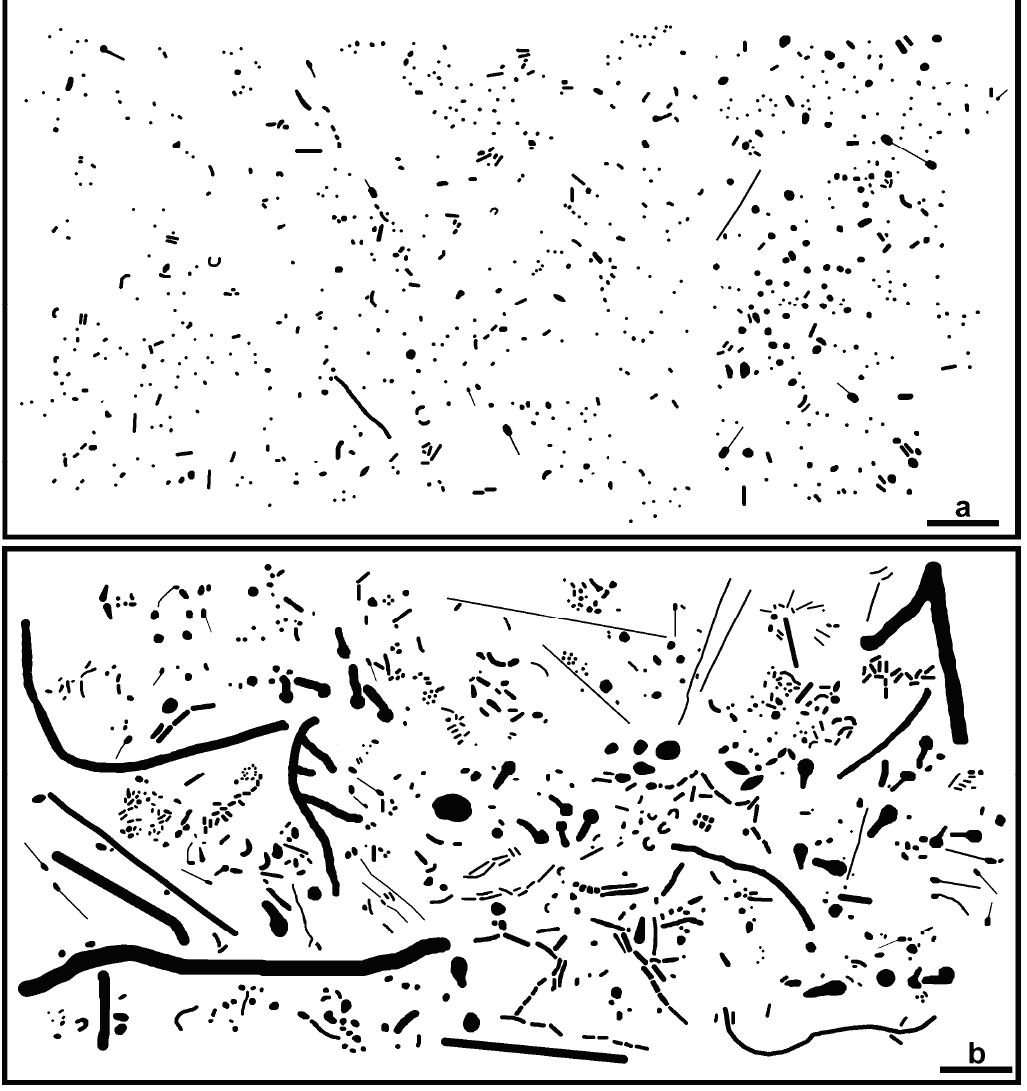
Figure 2. Microbial biofilm assemblages colonized on ( a ) control glass and ( b ) polystyrene slides incubated for four days in a flowing freshwater aquatic ecosystem. Bar scales equal 10.0 μ